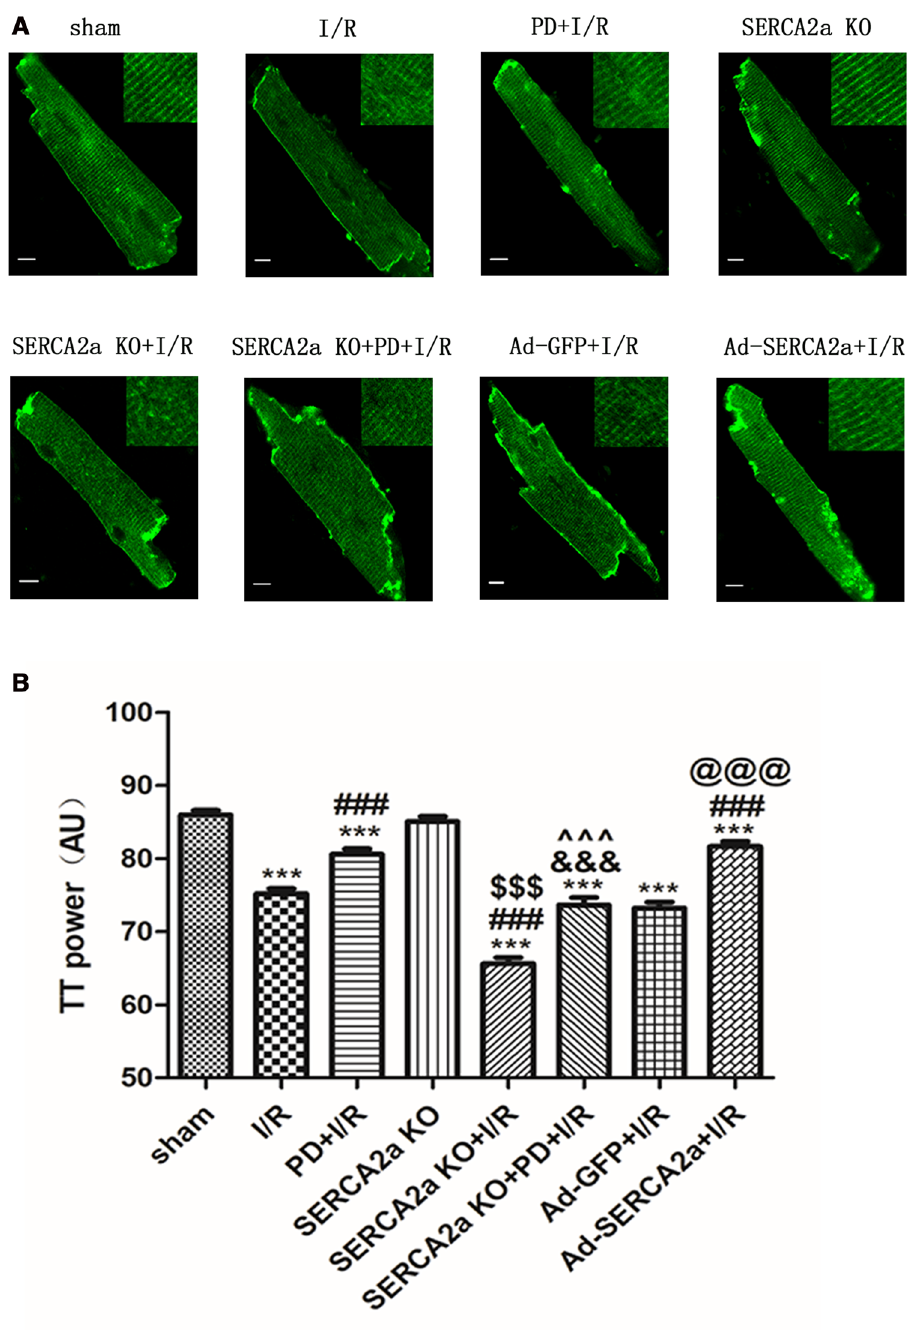
Figure 4. SERCA2a regulated T-tubule remodeling via calpain/JPH2 in myocardial I/R mice. ( A ) Confocal microscopy images of cardiomyocytes in each group stained with MM 4–64 (green), bar = 10 µm. ( B ) TTpower as a measure of T-tubule spatial organization in each group. Individual data points are presented in Supplemental Fig. 4B. *** P < 0.001 versus sham; ### P < 0.001 versus I/R; &&& P < 0.001 versus PD + I/R; $$$ P < 0.001 versus SERCA2a KO; ^^^ P < 0.001 versus SERCA2a KO + I/R; @@@ P < 0.001 versus Ad-GFP + I/R. n = 27 to 67 cells from 3–5 hearts per group; mean ±